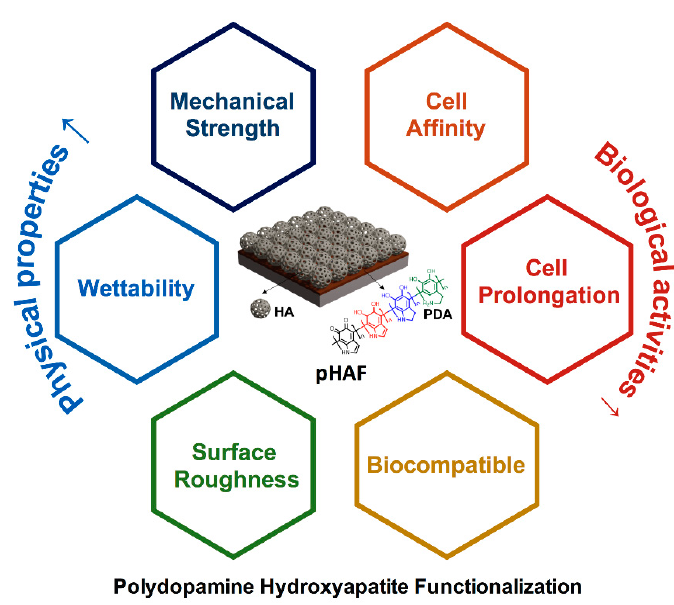
Figure 1. Polydopamine Hydroxyapatite Functionalization (pHAF) approach to improving the physical properties and biological properties for bone tissue engineering